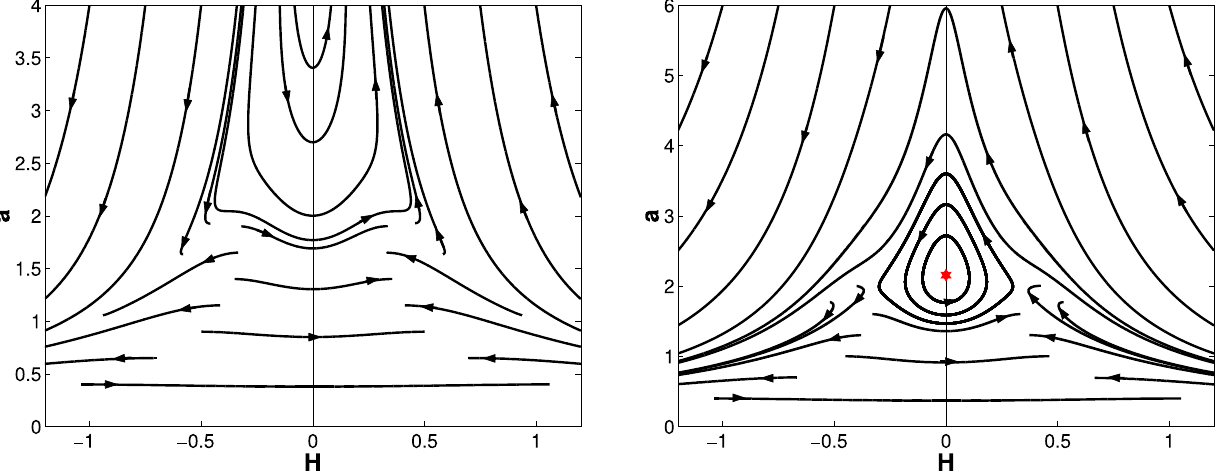
Fig. 3 The phase portraits are plotted for N = 3, f 0 = 1 dotted regions correspond to ρ < 0 in the constraint equation